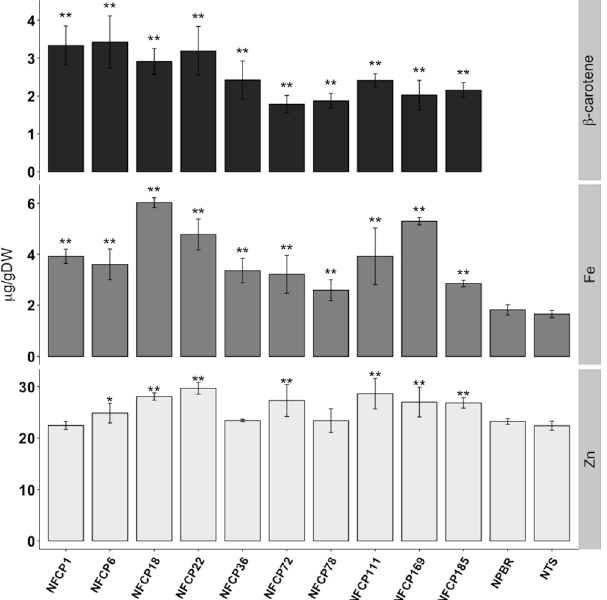
Figure 5. β -carotene and metal content of NFCP lines. β -carotene, iron (Fe) and zinc (Zn) content in polished grains of T3 NFCP lines. Values are the mean of three biological replicates ( ± SD). Asterisks above the bars indicate statistically significant differences calculated using Student’s T test, in comparison to the control line Nipponbare (NPBR) ( * P < 0.05; ** P < 0.01). NTS is the non-transgenic